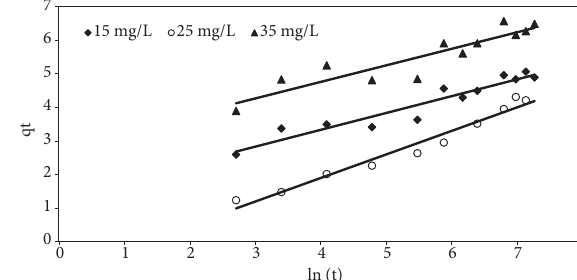
Fig. 10. Elovich Model for Cu 2+ adsorption onto the eggshell at various adsorbate